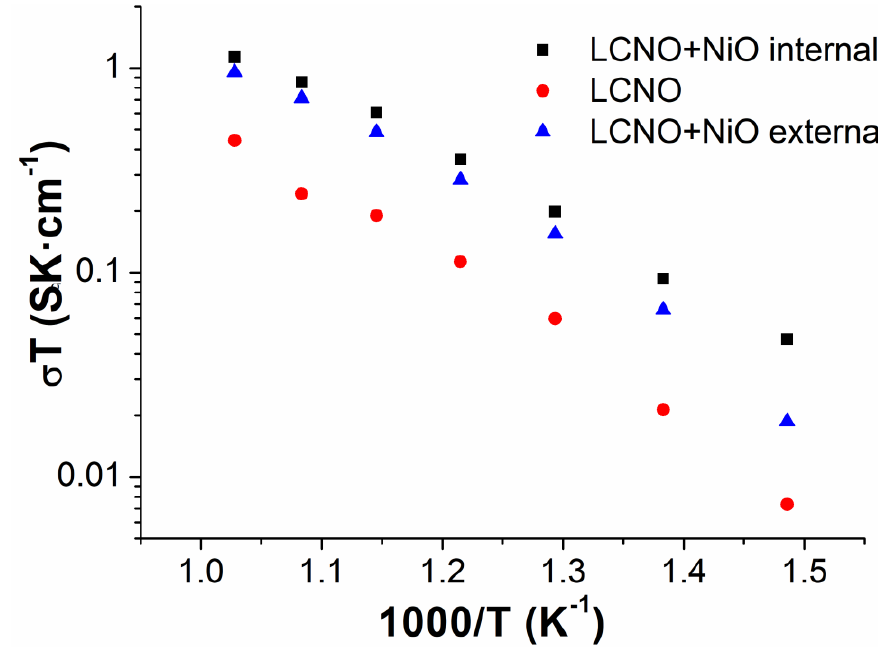
Figure 3. The conductivities of the LCNO pellet without NiO addition, and LCNO with 1 wt.% NiO addition externally and internally.